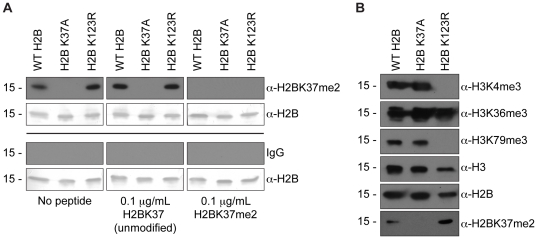
α-H2BK37me2 antibody is specific for dimethylated lysine 37 on histone H2B.(A) A polyclonal antibody was purified from antiserum raised by immunizing rabbits with the peptide SKARKme2ETYS-C, where me2 is dimethyl lysine. Peptide competition assay demonstrates specificity of purified α-H2BK37me2 antibody for dimethyl lysine 37 of histone H2B. Western blot analysis was completed using acid-extracted histones from strains harboring wild-type Flag-H2B (YKG001), Flag-H2B K37A (YKG007), and Flag-H2B K123R (YKG002), demonstrating that dimethylation of lysine 37 on histone H2B occurs in vivo, as the antibody is able to recognize this modification in wild-type and H2B K123R-derived histone samples, but not histones extracted from the Flag-H2B strain harboring a K37A mutation (No peptide controls: left column, upper panels). Preincubation of the purified antibody with H2K37me2 peptide resulted in a loss of the ∼15 kDa band in all three histone samples, whereas preincubation with unmodified H2BK37 peptide did not alter the reactivity (middle and right columns, upper panels). H2BK37me2 signal was not detectable in Western blot analysis using IgG purified from pre-immune serum (lower panels). All blots were stripped and reprobed with an α-H2B antibody to demonstrate equal loading. (B) Western blot analysis using modification specific antibodies indicates that mutation of lysine 37 on histone H2B does not affect methylation at other known sites of methylation in budding yeast, including histone H3 lysines 4, 36, and 79. A H2B K123R mutation abrogates methylation at H3K4 and H3K79, in agreement with previously published results [47], but does not affect H2BK37 methylation.